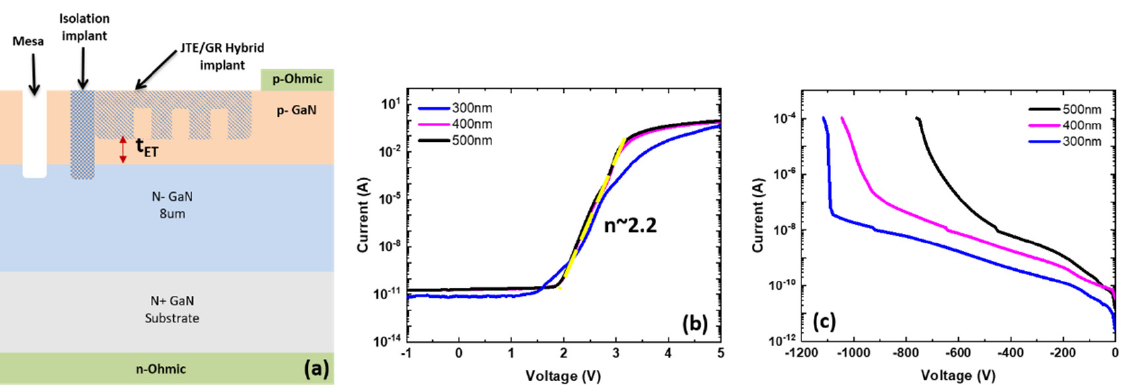
Figure 1. ( a ) Cross section schematic of the PiN Diode ( b ) I-V DC forward DC I-V sweep for the three samples in this work and ( c ) I-V DC forward DC I-V sweep for the three samples.